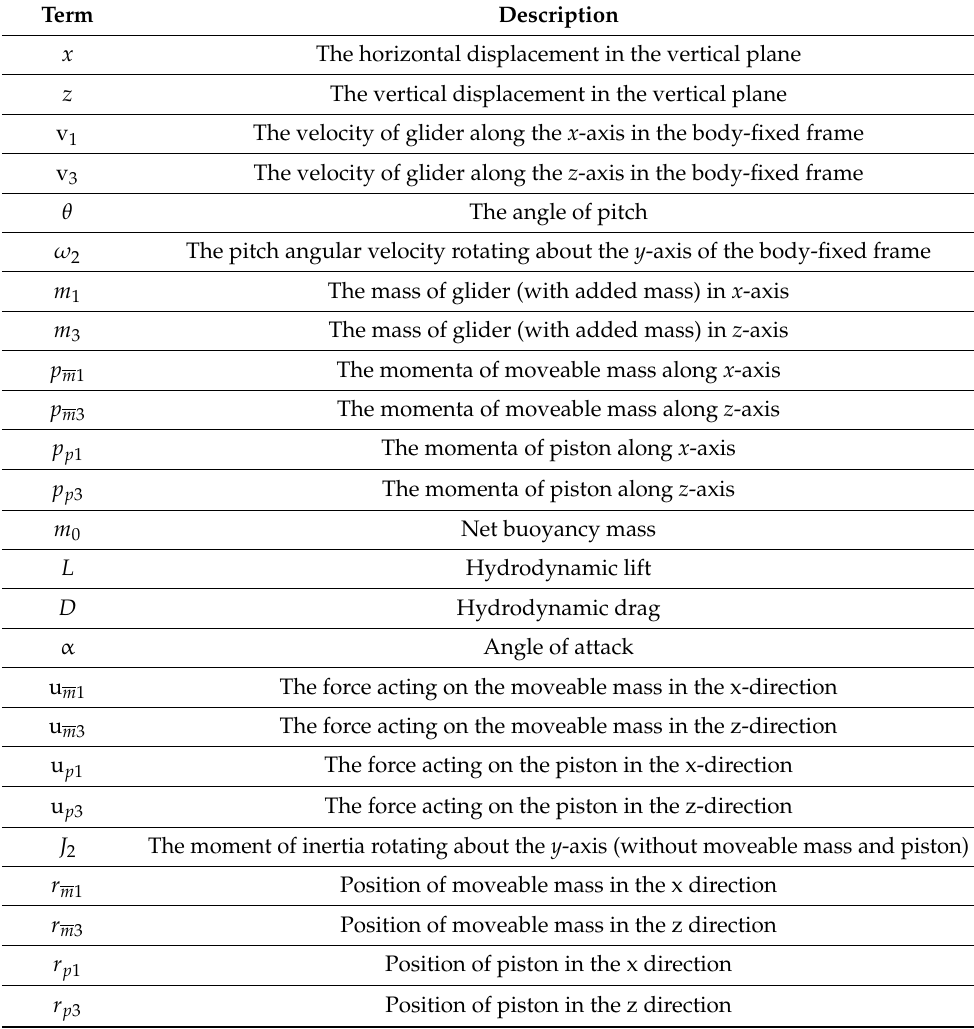
Table 1. Descriptions of parameters of above equations. Term